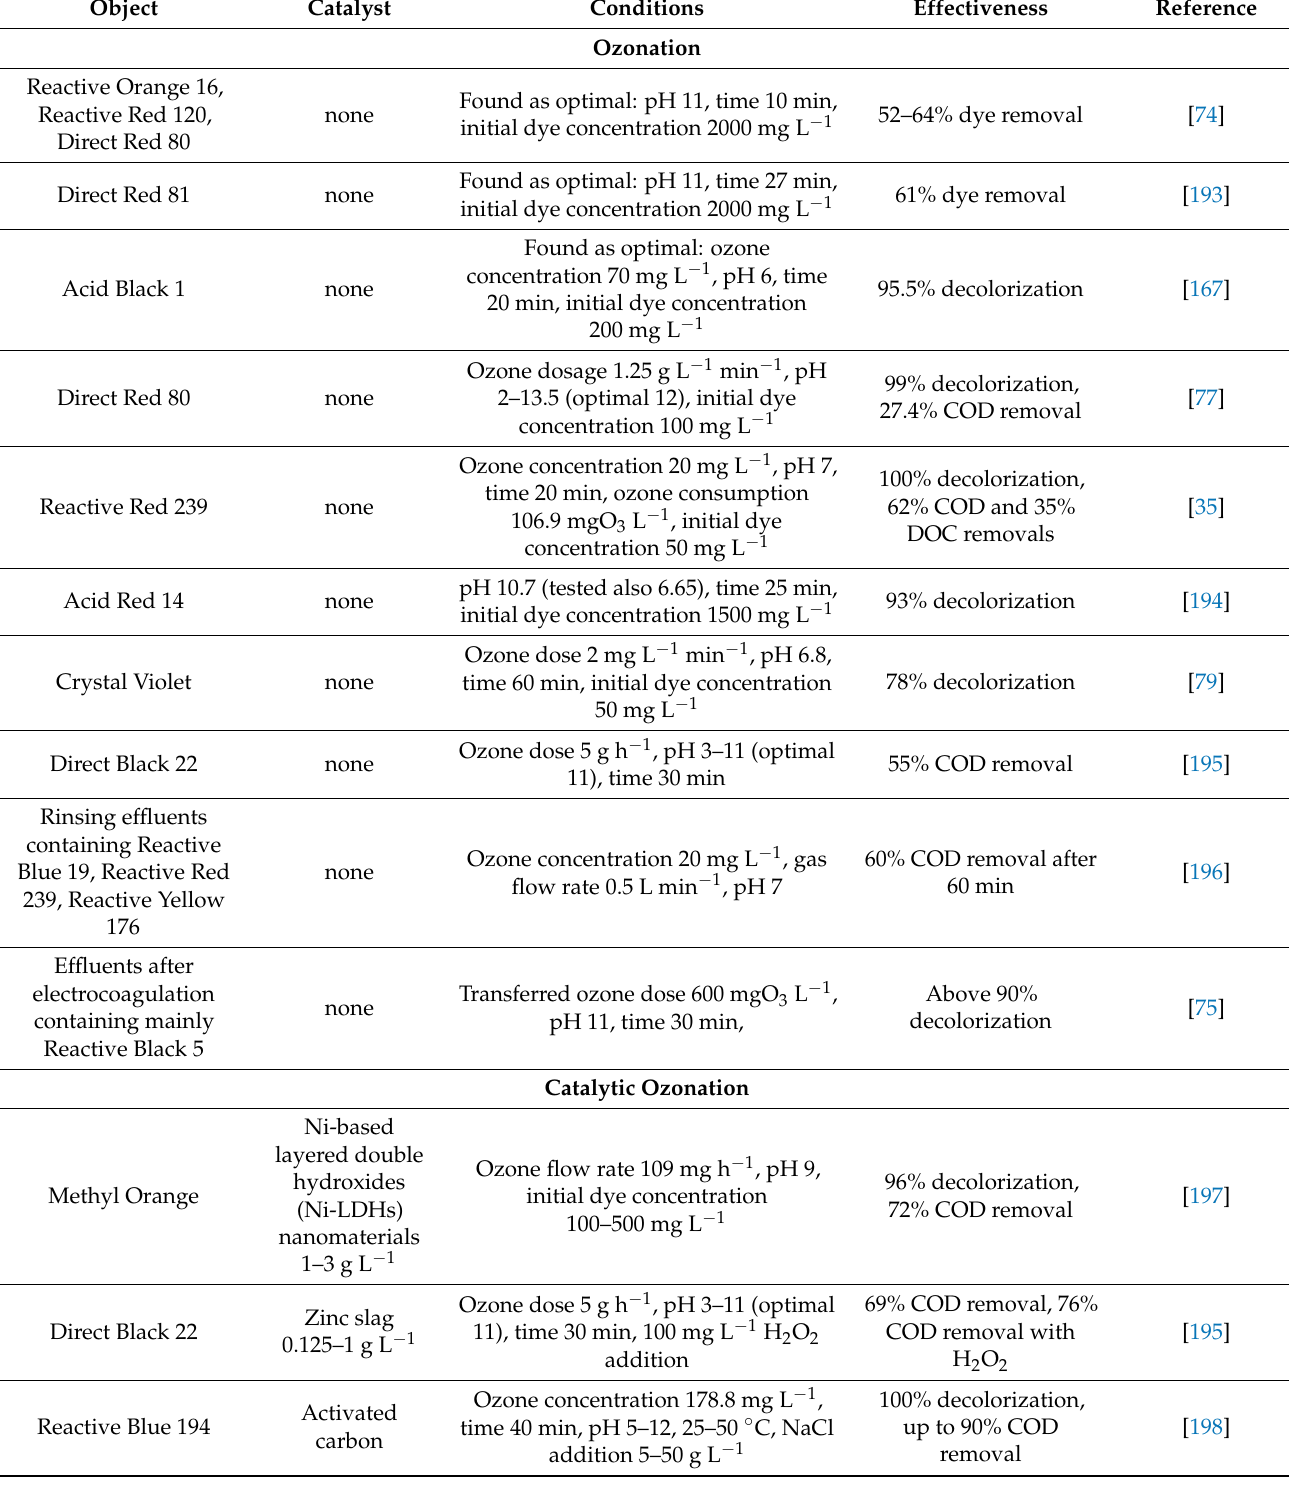
Table 3. Brief summary of dye removal using selected advanced oxidation processes (last three